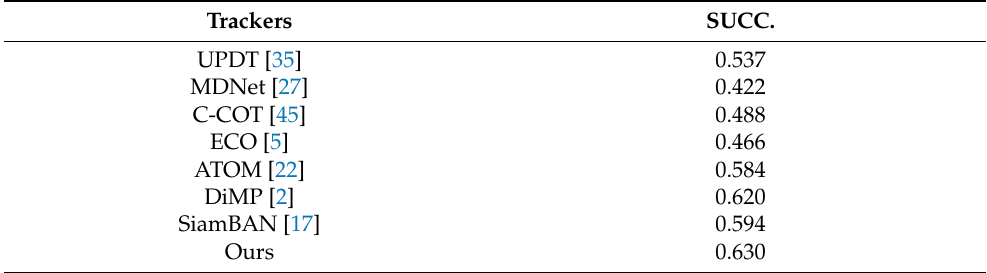
Table 3. Comparative results on